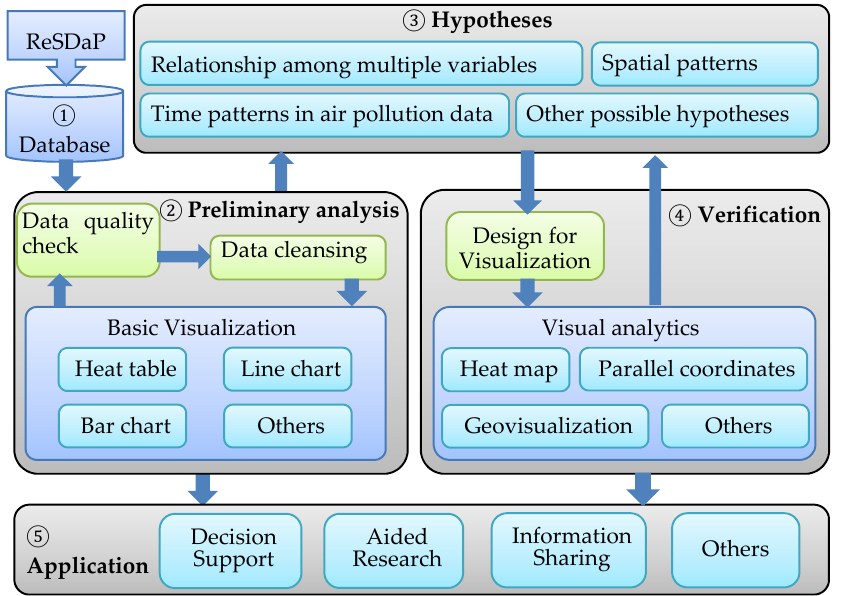
Figure 1. Visualization workflow for air pollution data.